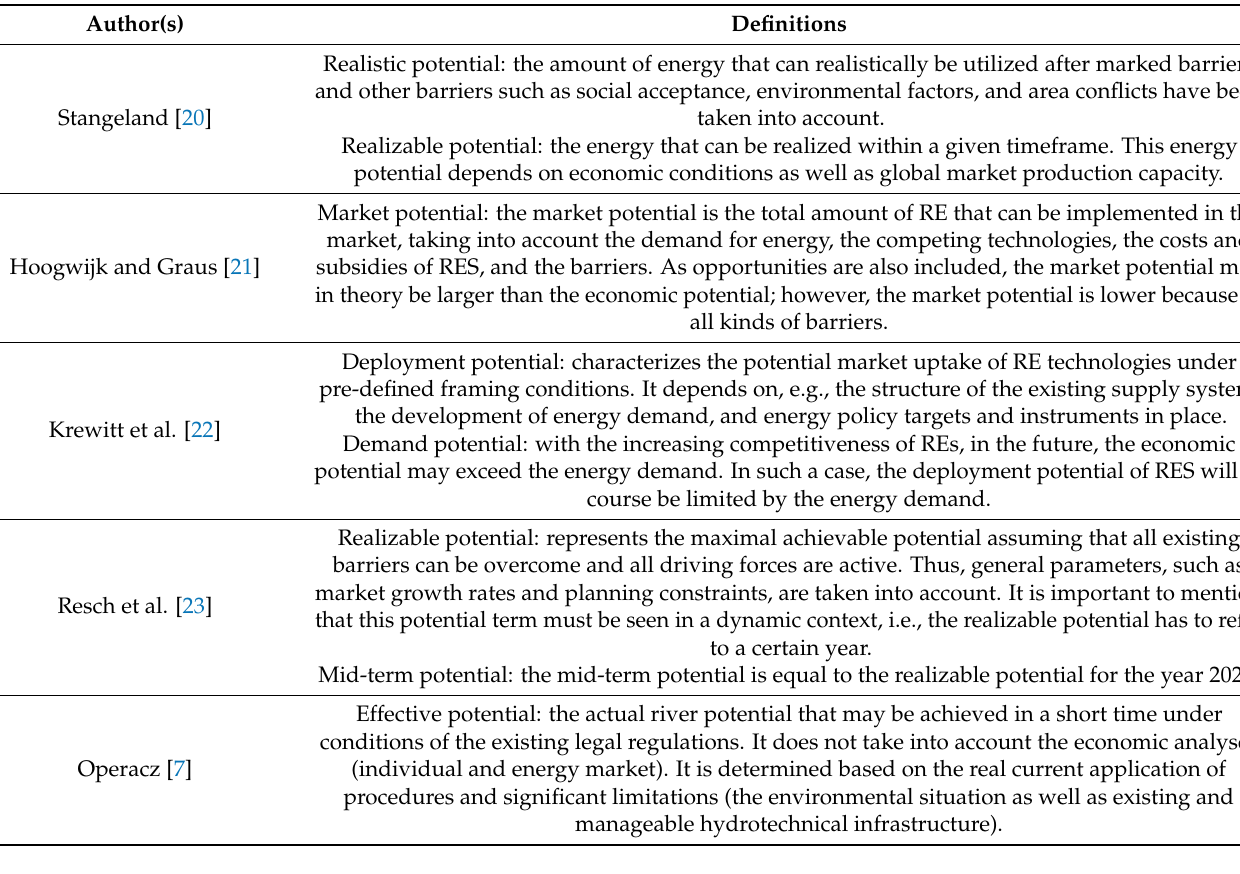
Table 1. Examples of the definitions of RE